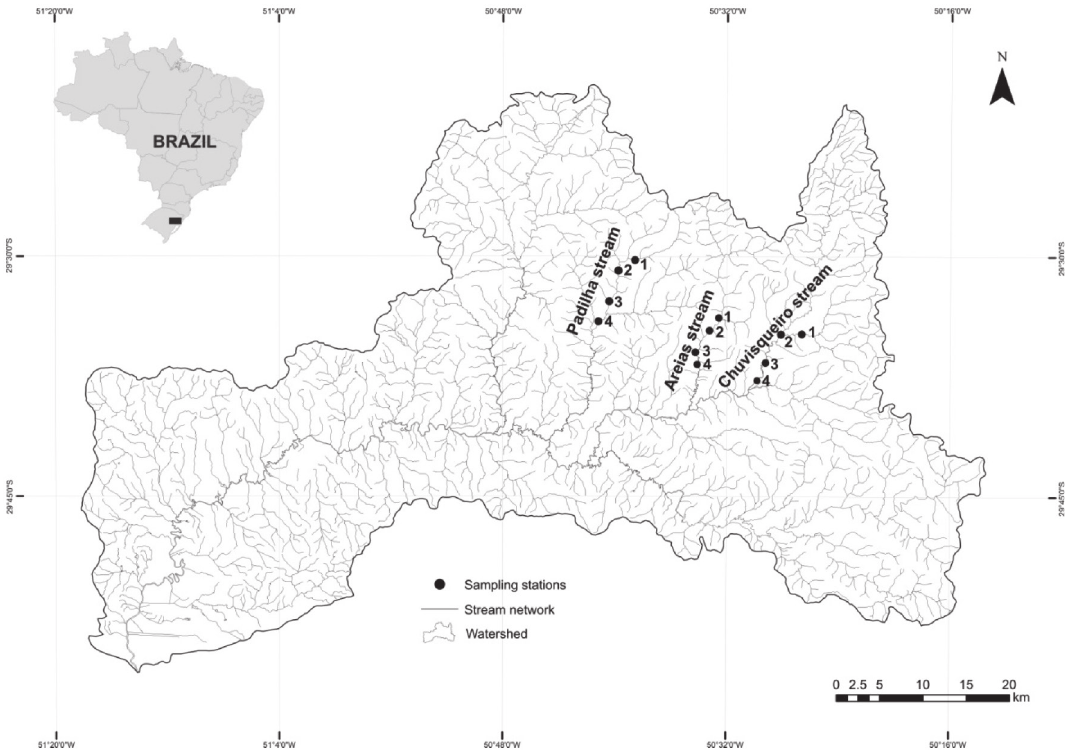
Figure 1 - Sinos River watershed delimitation and sampled